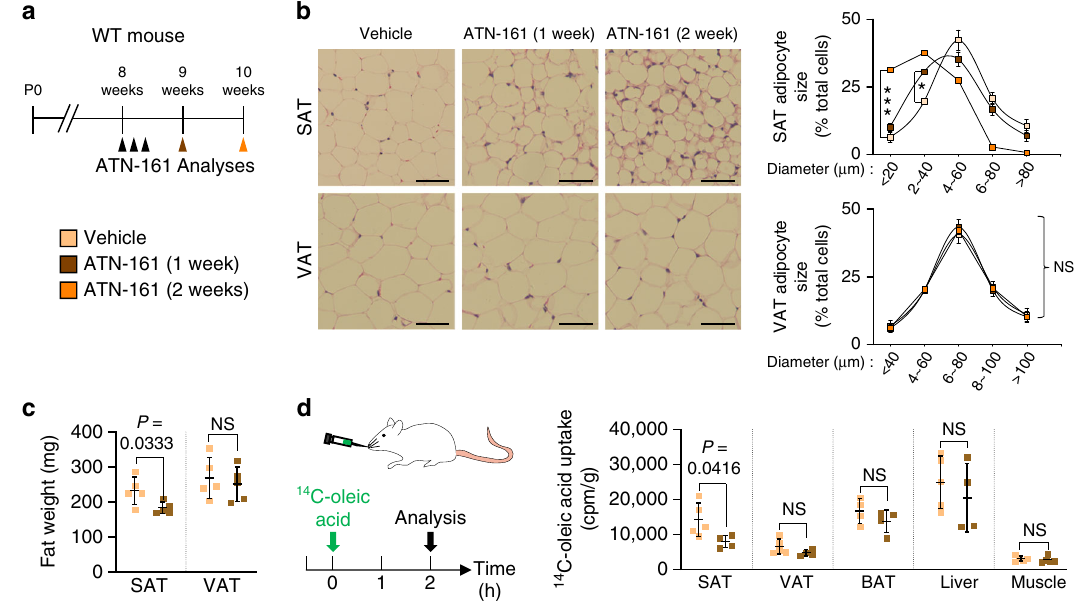
Fig. 7 Integrin α 5 β 1 drives subcutaneous fat distribution. a Diagram depicting experimental scheme for integrin α 5 β 1 antagonist treatment. 8-week-old WT mice were treated with integrin α 5 β 1 blocking peptide (ATN-161, 30 mg/kg) and analyzed 1 or 2 weeks later. Black arrowheads indicate injections of ATN-161. b Representative H&E-stained images and comparisons in adipocyte size (diameter; μ m) in SAT and VAT of ATN-161 treated mice. Four different mice of each genotype were randomly selected to determine the adipocyte size and data are presented as % of total cells. Horizontal bars indicate mean ± SD and * P < 0.05; *** P < 0.001 versus WT by two-tailed Student ’ s t test. Scale bars, 30 μ m. c Comparison of fat weight (mg) of SAT and VAT in ATN-161 treated mice. n = 5 for each group. Horizontal bars indicate mean ± SD and P values versus WT by two-tailed Student ’ s t test. NS, not signi fi cant. d Diagram of experimental scheme and comparisons of 14 C-oleic acid uptake in different adipose tissues and metabolic organs between vehicle and ATN-161 treated mice. 8-week-old WT mice were dosed with ATN-161, and administered with 14 C-oleic acid 1 week after. n = 4 (WT BAT; ATN-161 SAT, VAT, BAT, and liver), 5 (WT SAT, VAT, liver, and muscle; ATN-161 muscle). Horizontal bars indicate mean ± SD and P values versus vehicle by two-tailed Student ’ s t test. NS not signi fi